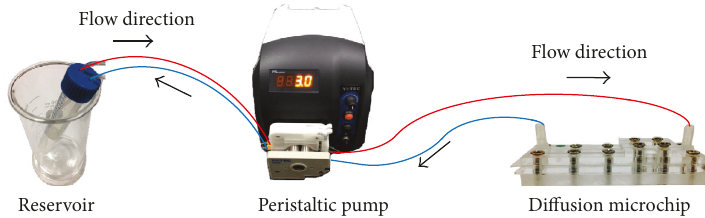
Figure 3: Schematic of the setup of the diffusion microchip system for evaluating transdermal delivery.